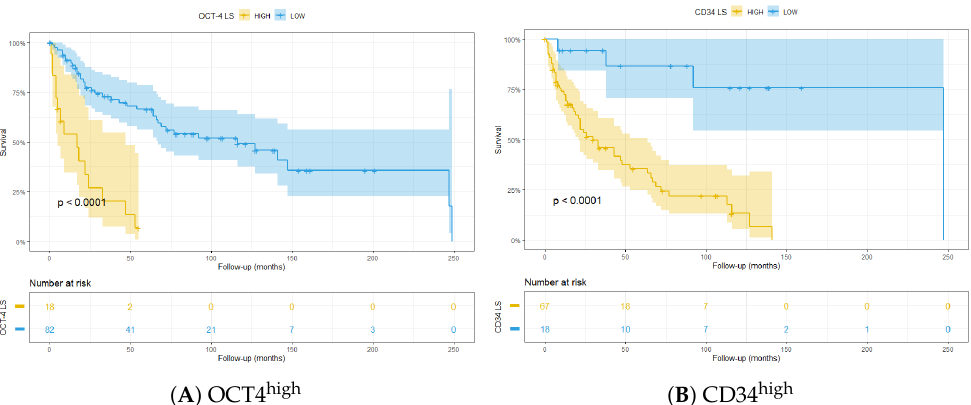
Figure 9. Kaplan–Meier plots showing stratification of patients with integrated LS using: ( A ) IF OCT4 high ; and ( B ) DSP CD34 high